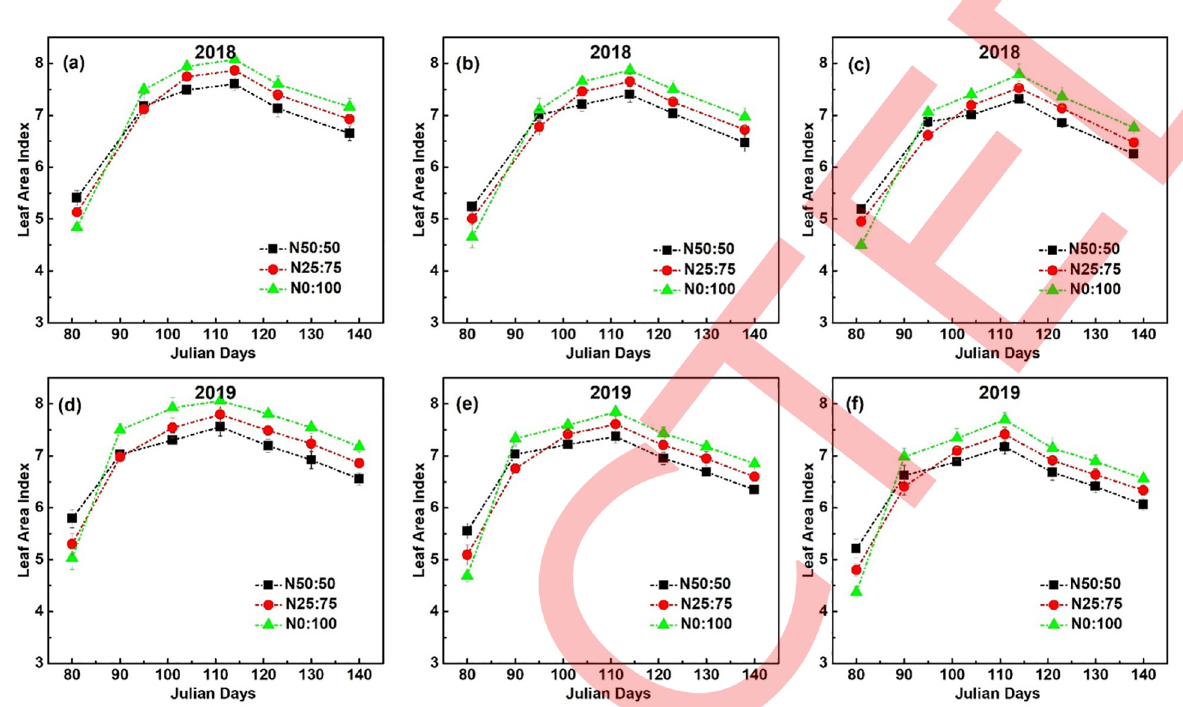
Fig 6. Leaf area index of winter wheat in (a) D 40 , (b) D 60, and (c) D 80 during the 2017–2018 and 2018–2019 growing season.